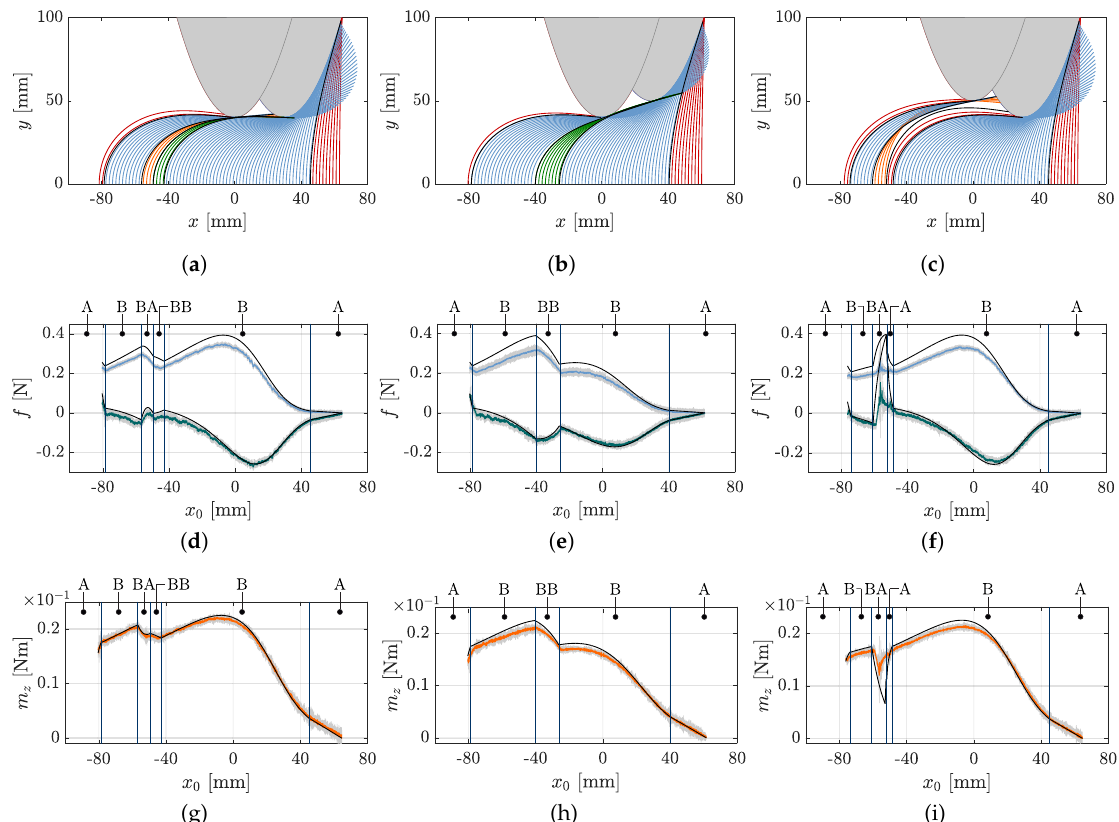
Figure 4. Scanning sweeps along object O1, O2 and O3: ( a – c ) elasticae (green: phase A, blue: phase B, orange: phase BA, red: phase BB, black: phase transitions); ( d – i ) simulated and measured support reactions (black: simulated data, green: measured data f 0 x , blue: measured data f 0 y , orange: measured data m 0 z , grey: standard deviation, black vertical lines: phase